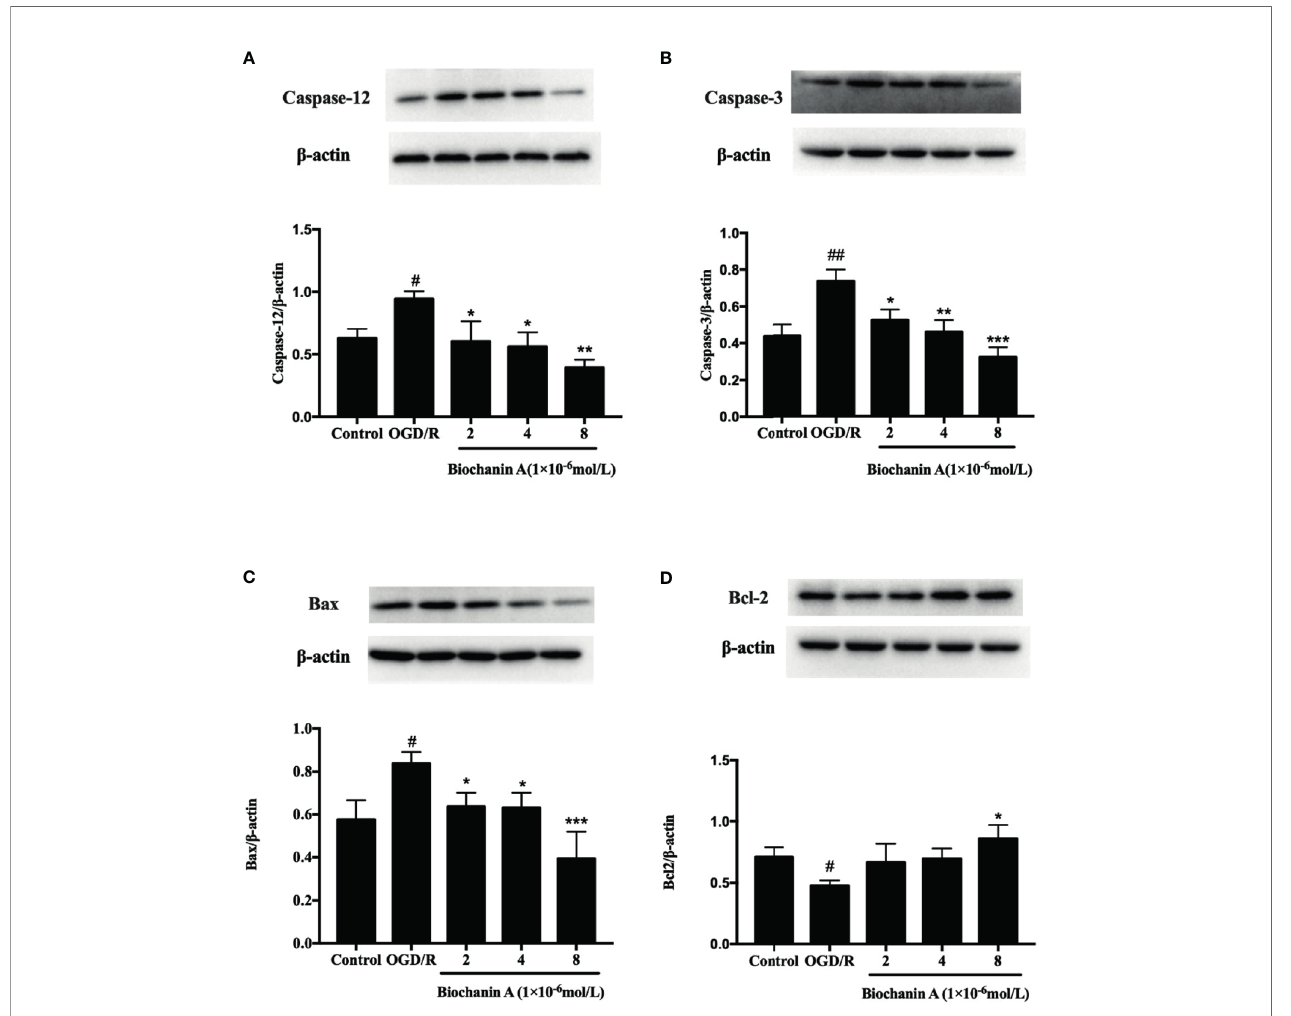
FIGURE 5 | The effects of biochanin A on apoptosis-related proteins in primary cortical neurons with OGD/R induction. Protein expression levels of caspase-12 (A) , capase-3 (B) , Bax (C) and Bcl-2 (D) were assessed by Western blot. b -actin were used as internal controls. Results were presented as mean ± SE, n = 3. # P < 0.05, ## P < 0.01, the OGD/R group vs. control group; * P < 0.05, ** P < 0.01, *** p < 0.001, vs. the OGD/R